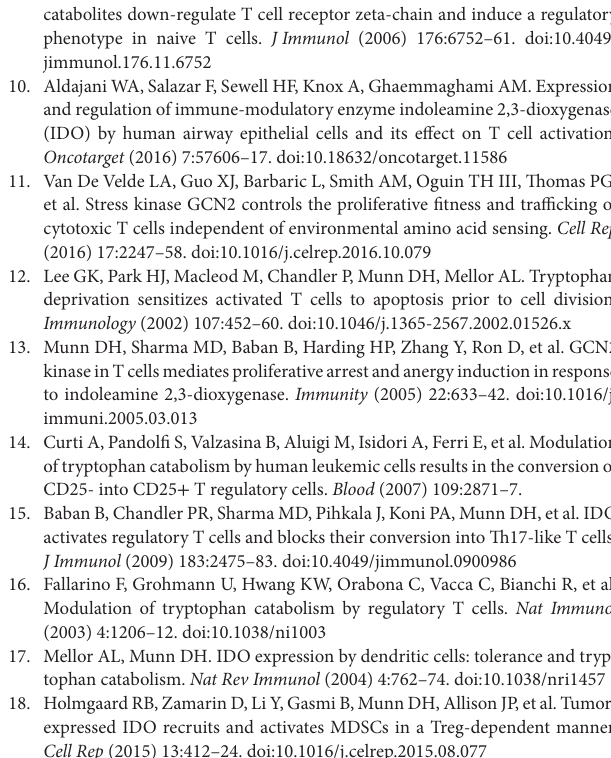
FigUre s1 | T cell numbers in relation to IDO expression patterns in primary cervical cancer. Scatter plots show stromal and intratumoral numbers per square millimeters for (a) CD8 + T cells, (b) CD8 + T cell/Foxp3 + Treg ratio, and (c) CD8 + Ki67 + T cells in tumors without IDO-positive tumor-infiltrating immune cells (IDO − infiltrate, white dots, n = 14) and with IDO-positive tumor-infiltrating immune cells (IDO + infiltrate, black squares, n = 17). Scatter plot shows (D) intratumoral numbers of CD8 + Ki67 + T cells in different groups of primary tumor expression patterns. P values were calculated in (a–c) using Mann–Whitney U test and unpaired t test in case of normal distribution of data. P values were calculated excluding subgroups with n = 2 or smaller (*) in (D) using Kruskal– Wallis test. * P = 0.01–0.05, ** P = 0.01–0.001, and *** P <